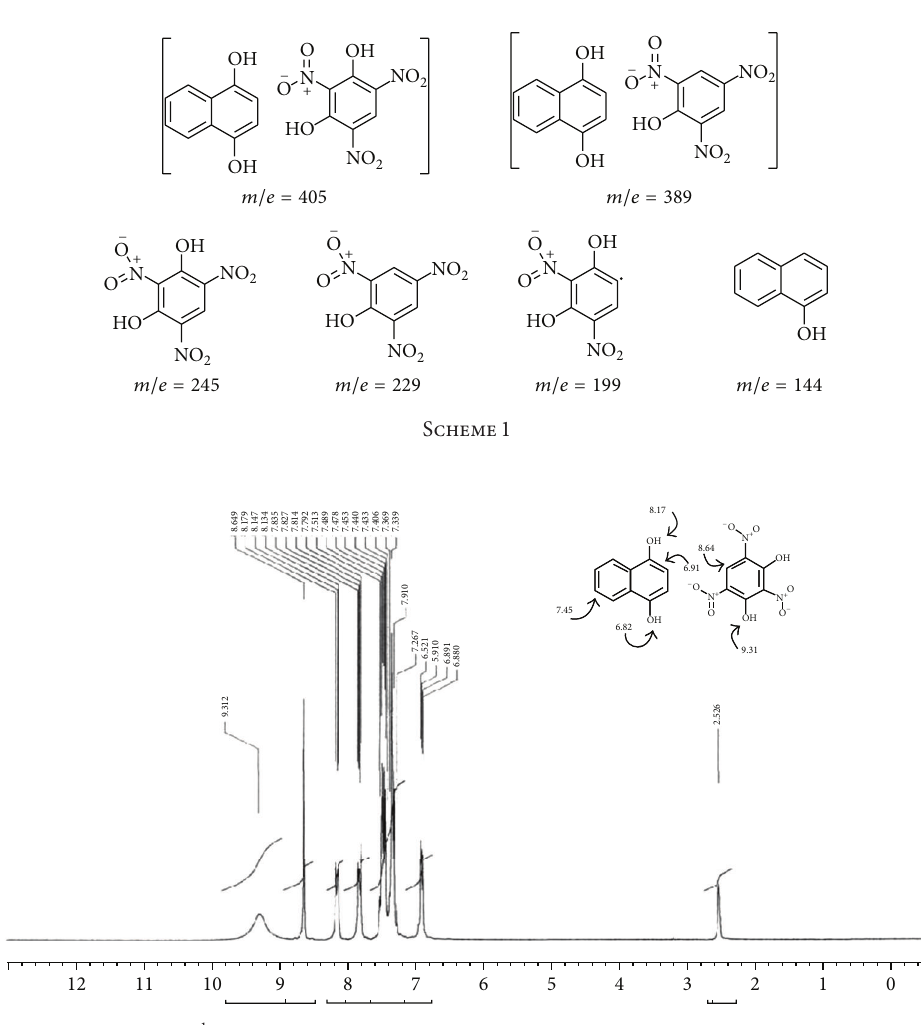
Figure 1: 1 H NMR spectrum of naphtalene-1,4-diol and styphnic acid